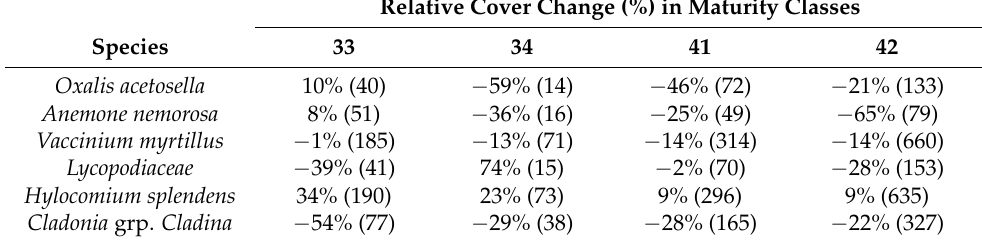
Table 5. Relative change in cover of species where maturity class (stand age proxy) was a significant ( p < 0.05) factor explaining the observed variation. The sample size in given in parenthesis. For definition of maturity classes see Table 1.